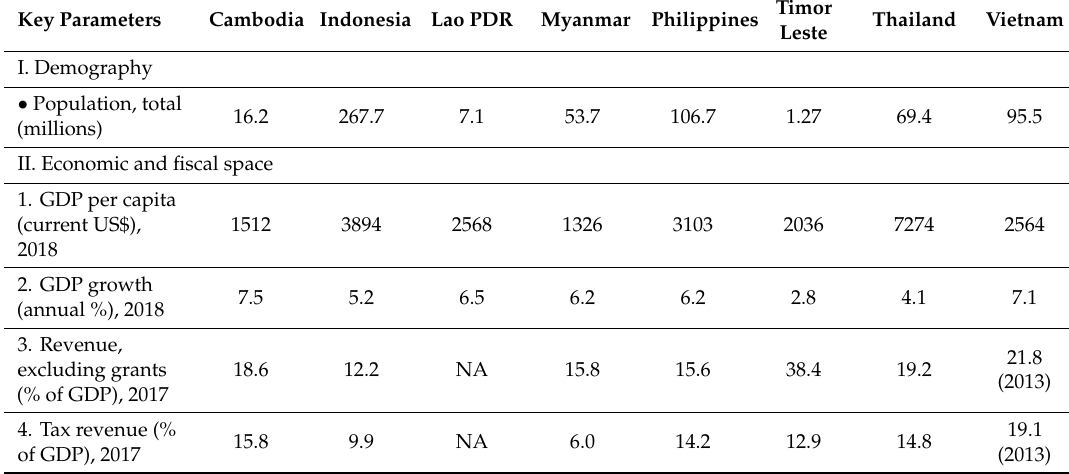
Table 1. Countries at a